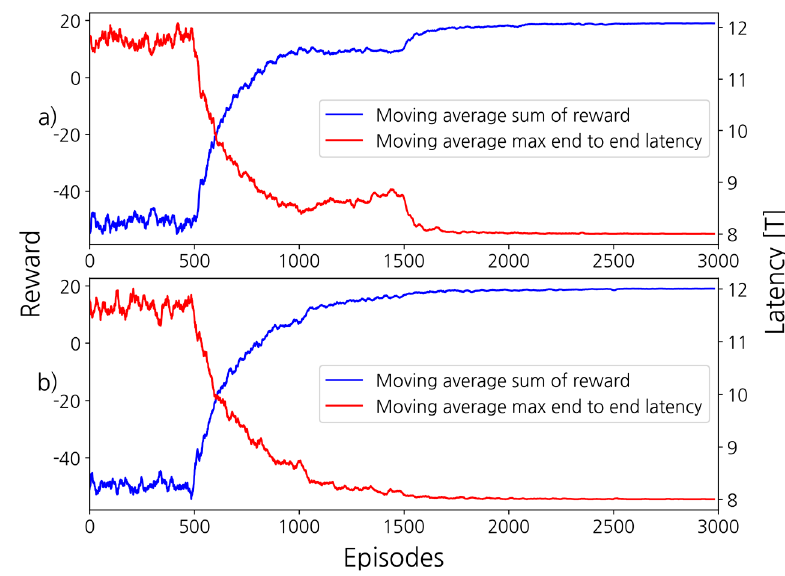
Figure 11. Training result of RL model in topology 2. ( a ): SARL, ( b ): MARL.